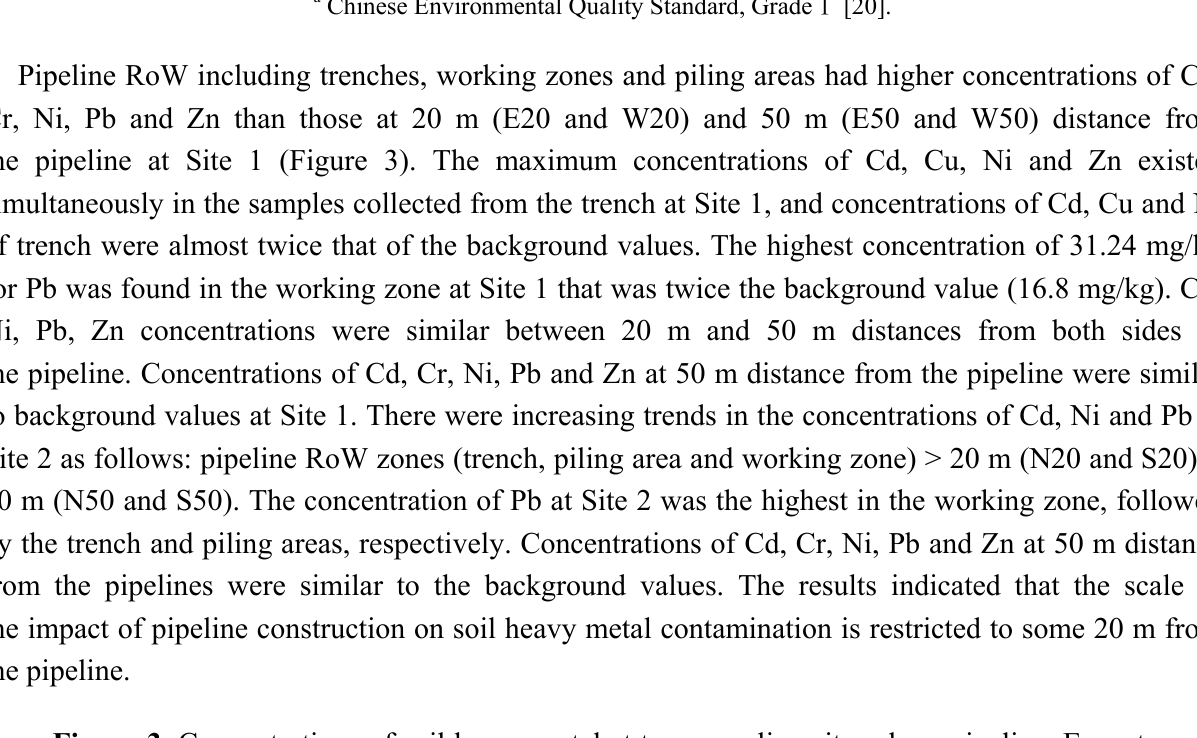
Figure 3. Concentrations of soil heavy metal at two sampling sites along pipeline. E: east, W: west, N: north, S: